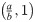
Coordinates for a two-component binary proportional system.Proportional variation for vectors, (a, b) and (c, d), is represented either as points, (ab,1) and (cd,1), in P1, or as points in the standard one-simplex, △1. δ is the proportional displacement between the vectors. Proportion and ratio are related by a linear fractional transformation, as indicated by the dashed lines.